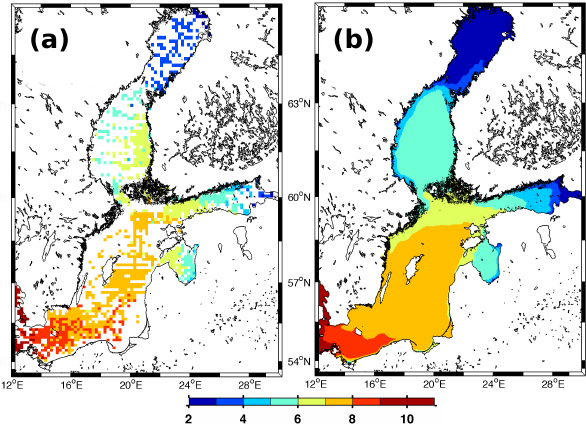
Figure 5. Sea surface salinity (PSU) averaged over 1987 to 1999. Panel (a) shows a composite based on ICES bottle observations (upper 10m, binned monthly into boxes of 6nm resolution and subsequently averaged over time). Panel (b) refers to MOMBA. Note that the actual model domain extends further into the North Sea (c.f. Fig. 1 a). Figure 6. Eddy kinetic energy, calculated based on surface velocities according to Eq. (16) in units of cm 2 s − 2 .